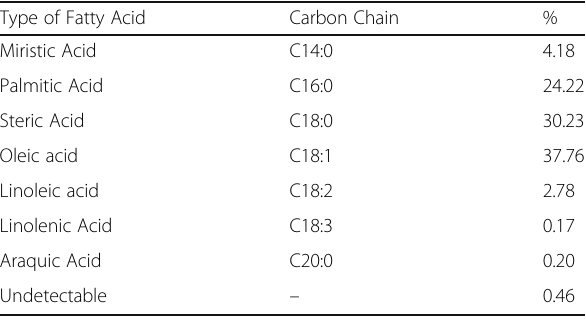
Table 2 Main fatty acids present in the fat extracted